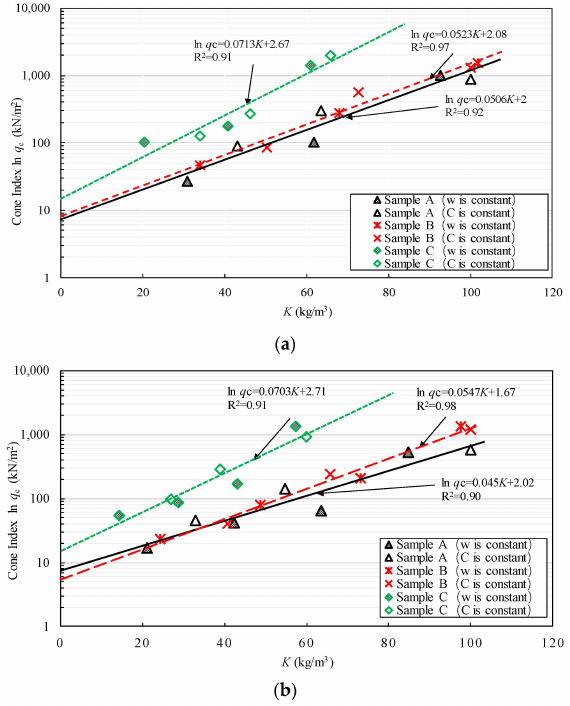
Figure 11. Relationship between ln q c and K for clay stabilized by OPC or DF. ( a ) Stabilized clay by OPC, ( b ) Stabilized clay by